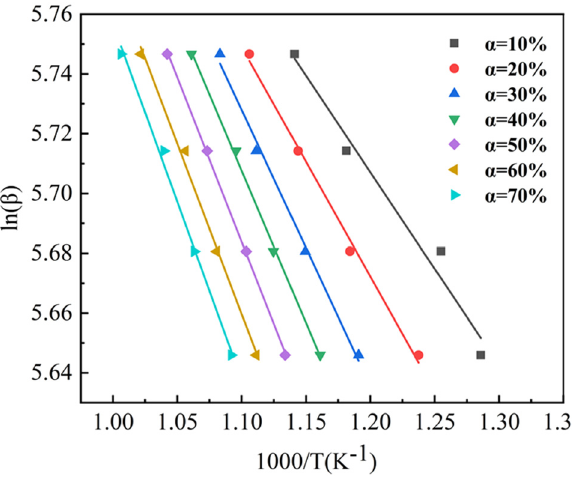
Figure 12: FWO method plots of sample K5 in di ff erent conversion degrees.